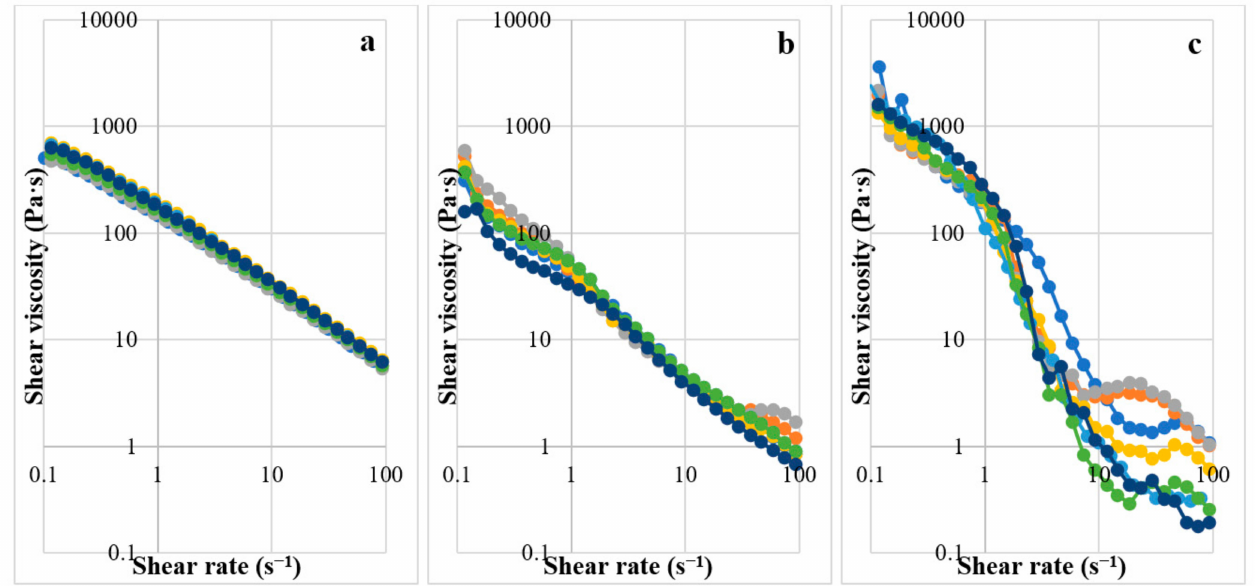
Figure 5. Flow curves of the gels prepared from ( a ) 4% carboxymethyl cellulose (CMC), ( b ) 5% low molecular weight chitosan (LMCS), and ( c ) 6.25% high molecular weight chitosan (HMCS) with different glycerin concentrations (1–7%).